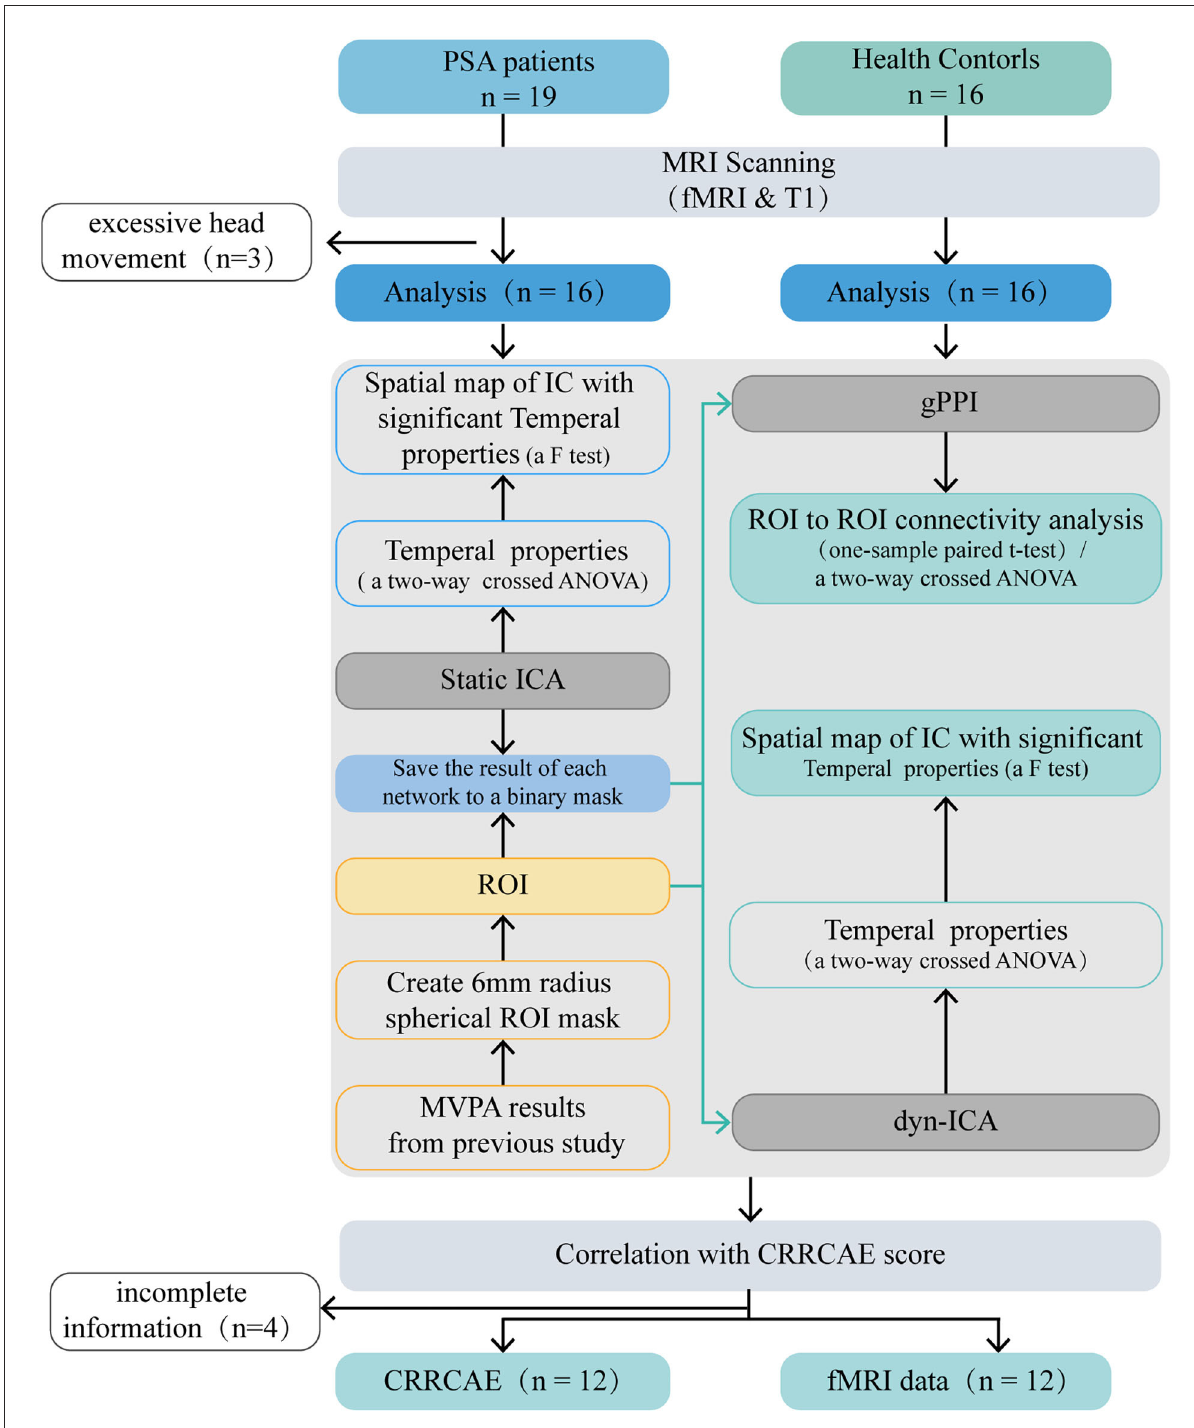
FIGURE1 Flow diagram. PSA, post stroke aphasia; gPPI, general psychophysiological interaction; dyn-ICA, dynamic independent component analysis; static ICA, static independent component analysis; CRRCAE, Chinese Rehabilitation Research Center for Chinese Standard Aphasia Examination; ANOVA, analysis of variance; ROI, region of interest; MVPA, multi-voxel pattern